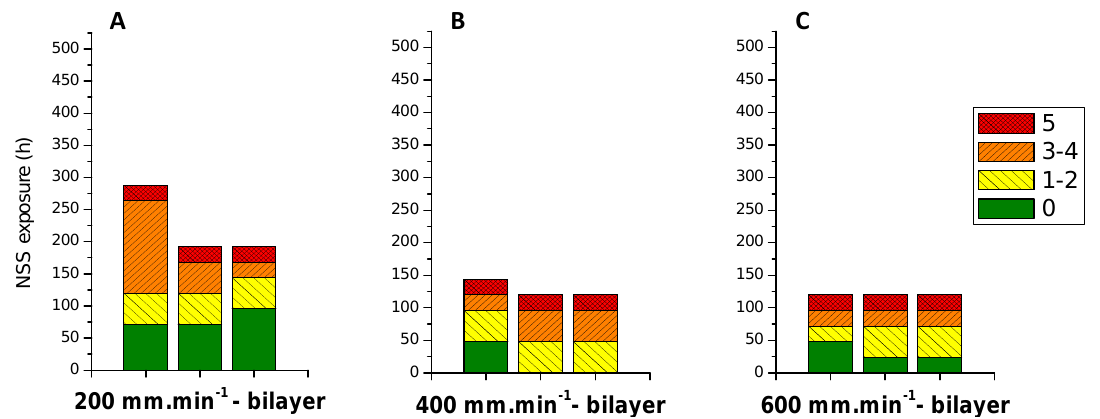
Figure 11. Corrosion resistance to NSS test for bilayer systems obtained from different withdrawal speeds. ( A ): 200 mm · min − 1 ; ( B ): 400 mm · min − 1 ; ( C ): 600 mm · min − 1